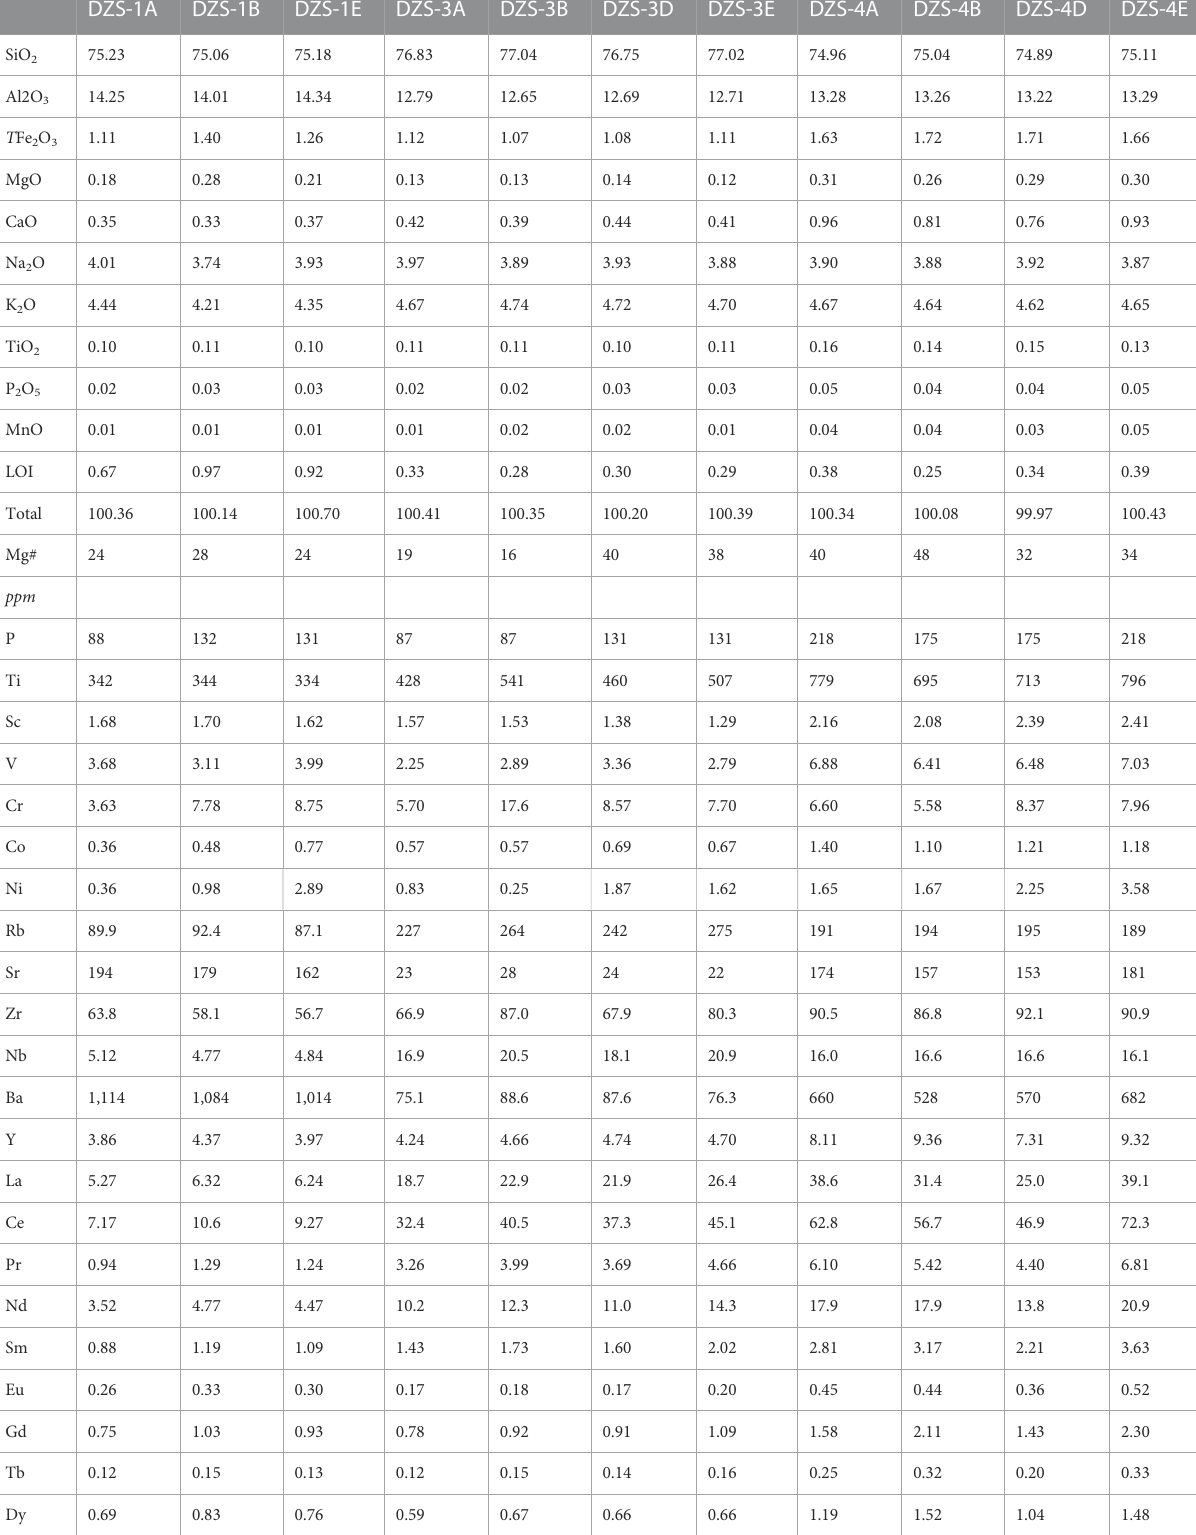
TABLE 1 Major ( wt % ) and trace ( ppm ) element concentrations for igneous rocks in the Dazeshan